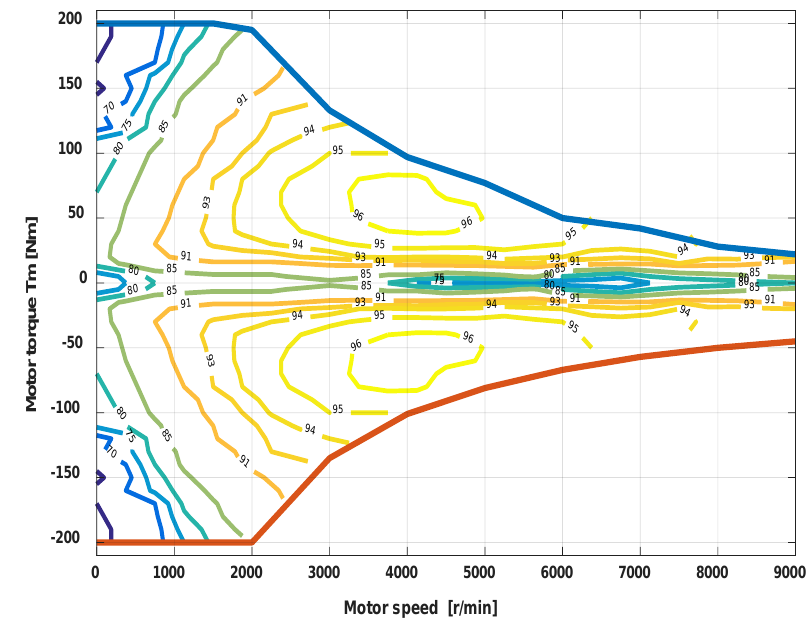
Figure 2. E ffi ciency map of an electric motor. Figure 2. Efficiency map of an electric motor. Table 1. The main technical parameters of the two-speed pure electric